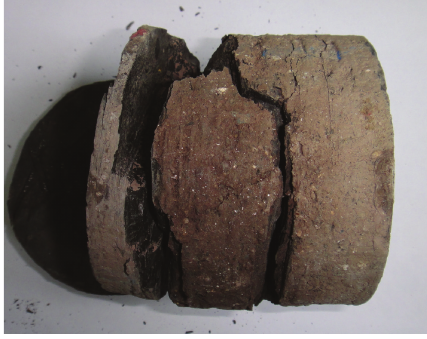
Figure 2: The core of Nahr Umr Shale.